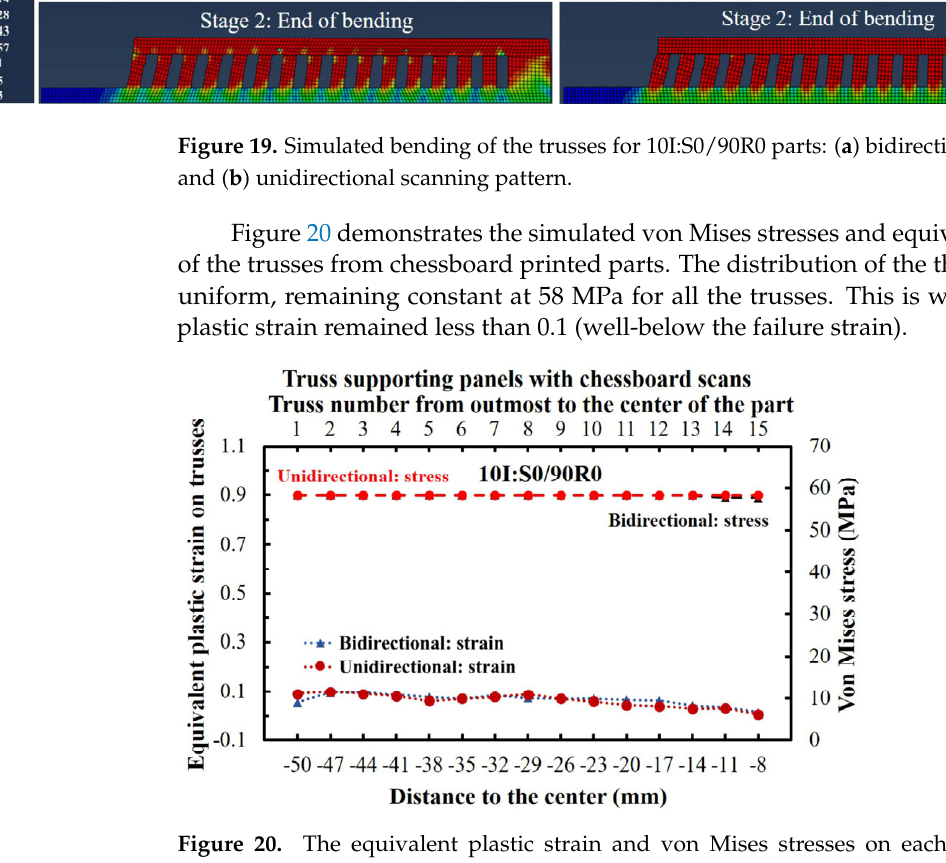
Figure 18. The bending angle and maximum shear strain (derived from maximum bending angle) of the chessboard printing.